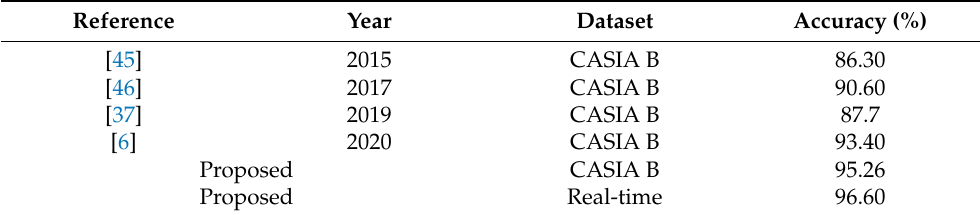
Table 7. Comparison with existing techniques for CASIA B